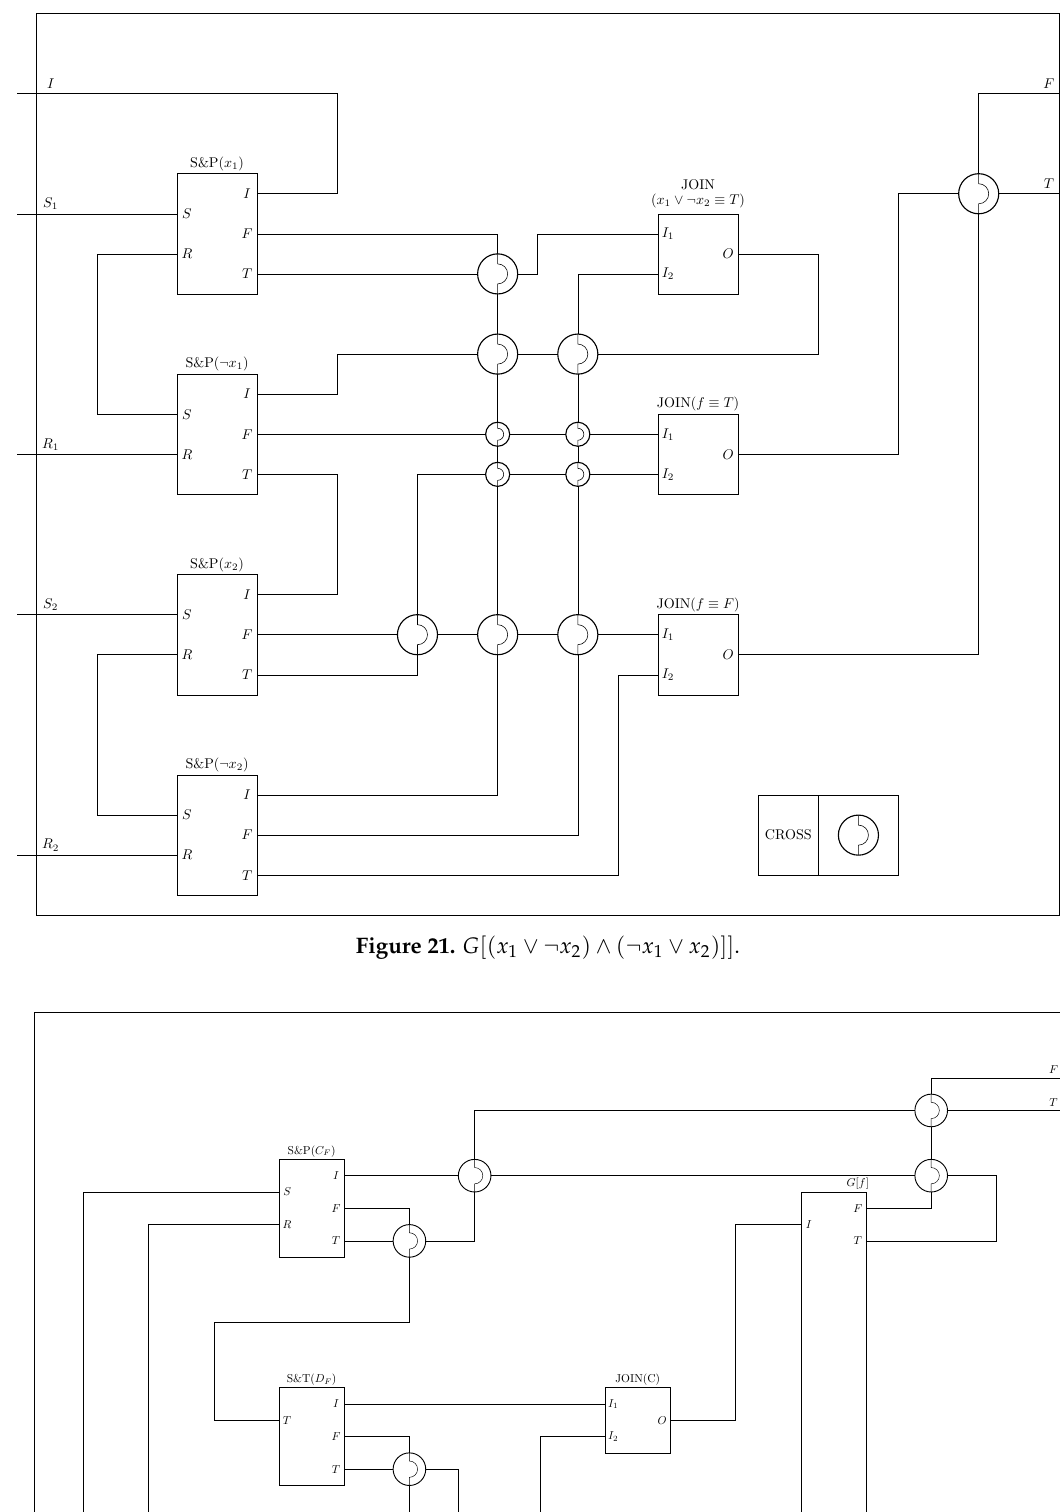
Figure 22. G [( ∀ x ) f ]]